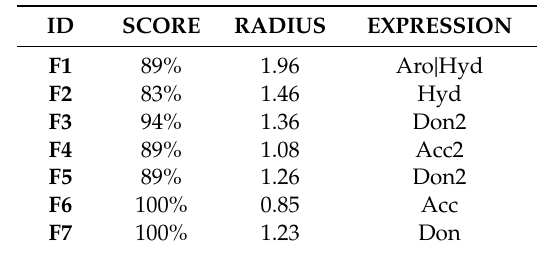
Table 1. List of pharmacophore features shared by 80% of the oxazolines acting as h TAAR1 agonists, along with their ID, score, radius and expression parameters. Pharmacophore features: Aro = aromatic; Hyd = hydrophobic; Don = hydrogen bond donor; Acc = hydrogen bond acceptor.